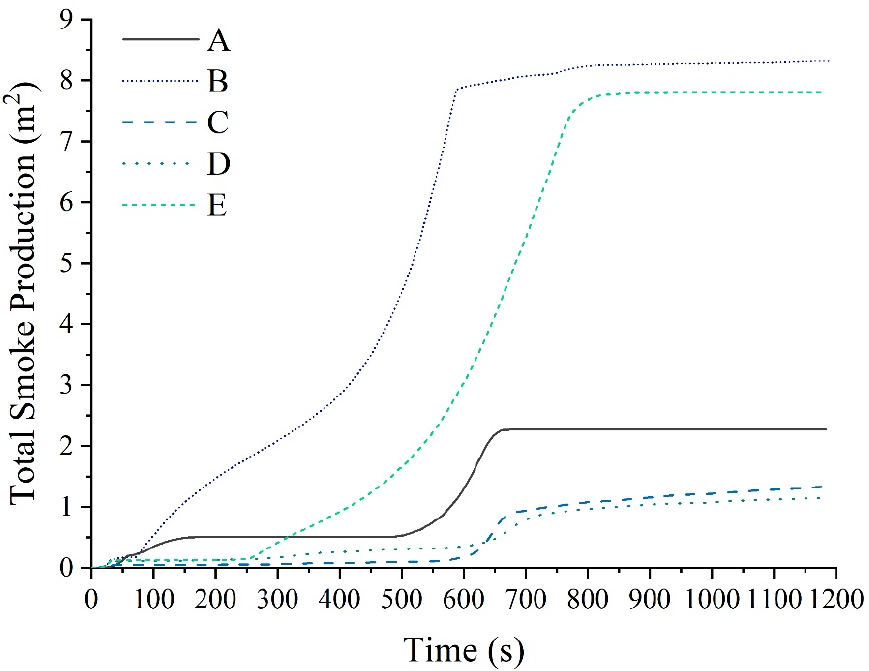
Figure 17. Total Smoke Production versus time for all the